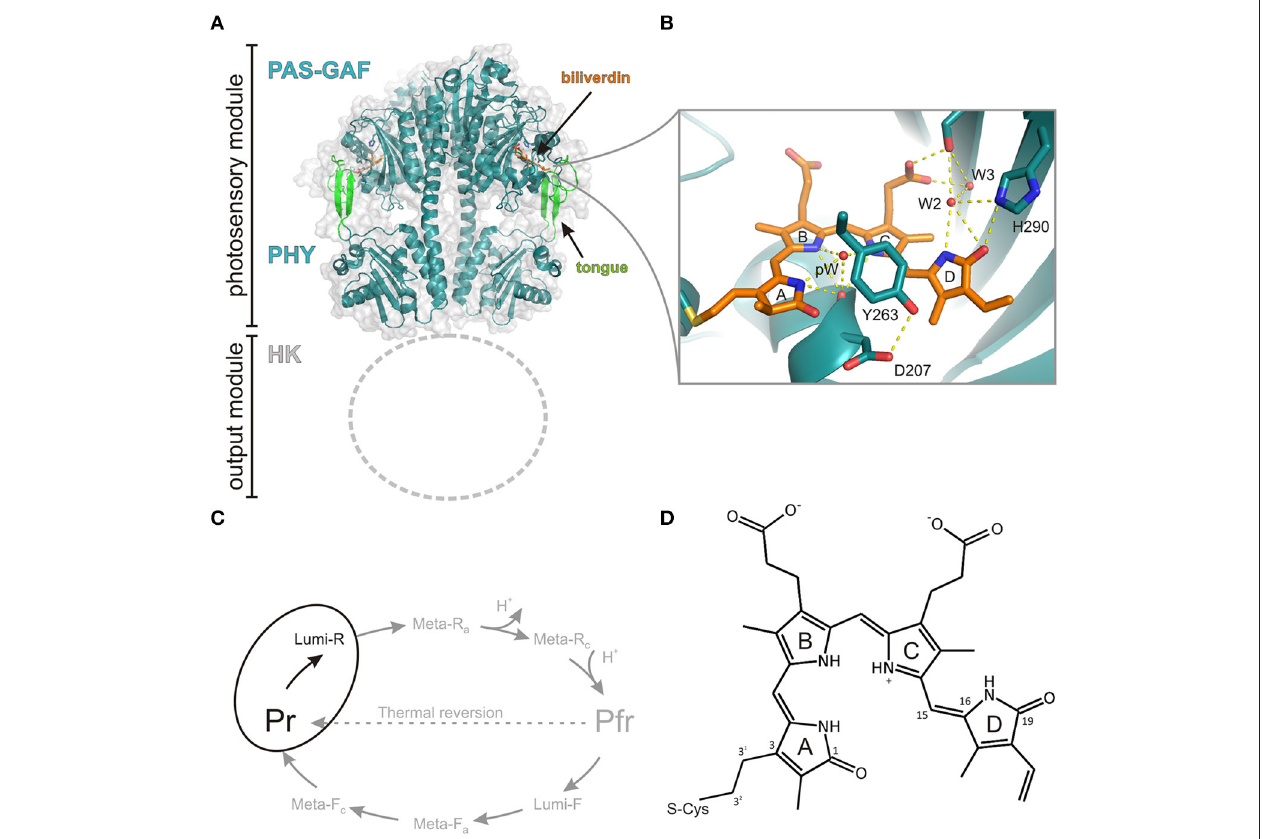
FIGURE 1 | Structure and photocycle of a canonical phytochrome from Deinococcus radiodurans . (A) The photosensory module of the phytochrome (PDB code 4O0P, Takala et al., 2014a) forms a parallel dimer that consists of chromophore-binding PAS and GAF domains, which are followed by a PHY domain. Due to the lack of structural information, the N-terminal histidine kinase (HK) domain is not shown. (B) A closed view of the biliverdin chromophore and its selected interactions to three water molecules pW (pyrrole water), W2, W3 and amino acids (Asp207, Tyr263, and His290). The panel is based on the high-resolution structure of the CBD fragment (PDB code 4Q0H, Burgie et al., 2014b). (C) Photocycle of the phytochrome with its intermediates. In this study, we concentrate on the first step of the forward reaction (Pr - > Lumi-R), highlighted in black. (D) The structure of the biliverdin molecule. The key atoms are